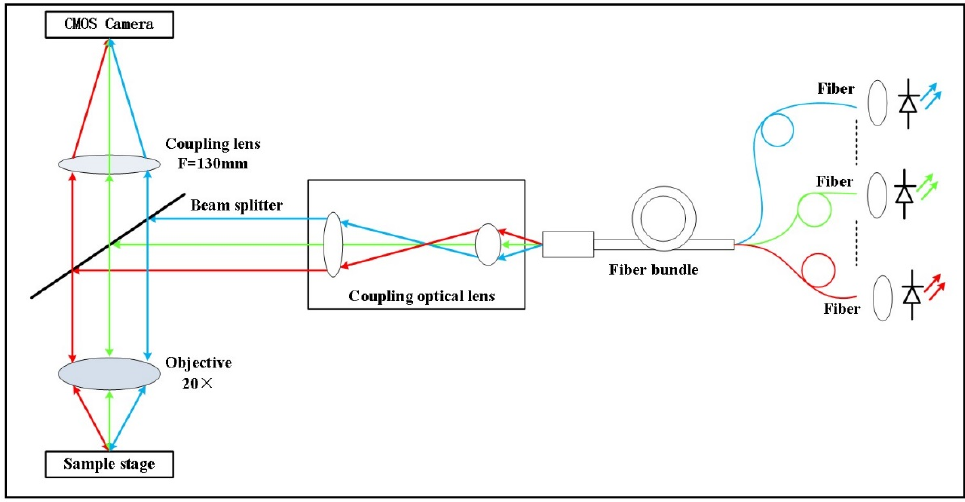
Figure 1. Optical schematic diagram of the system. Table 1. System performance parameters. Table 1. System performance